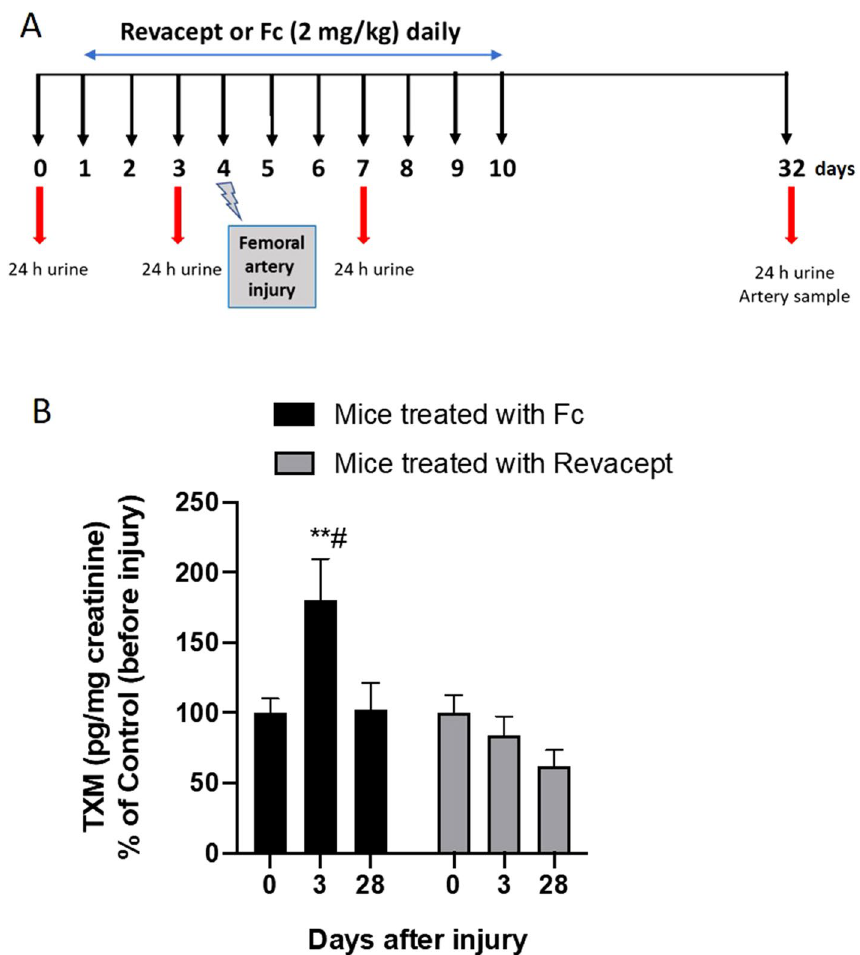
Figure 5. Effects of Revacept administration on urinary levels of TXM in mice in response to injury. ( A ) Study design of Revacept or Fc-control (2 mg/kg/day) administration to mice using a model of neointima formation caused by the damage of femoral arteries via transluminal wire injury. ( B ) Urinary levels of TXM were assessed at different time-points, before (0) and after vascular injury (3 and 28 days) in mice treated with Fc control or Revacept (2 mg/kg/day); data are expressed as mean ± SEM, n = 9–10; ** P < 0.01 versus the other Fc conditions, # P < 0.05 versus the conditions of Revacept after injury (using mixed-effects analysis for repeated measures data and Tukey’s multiple comparisons